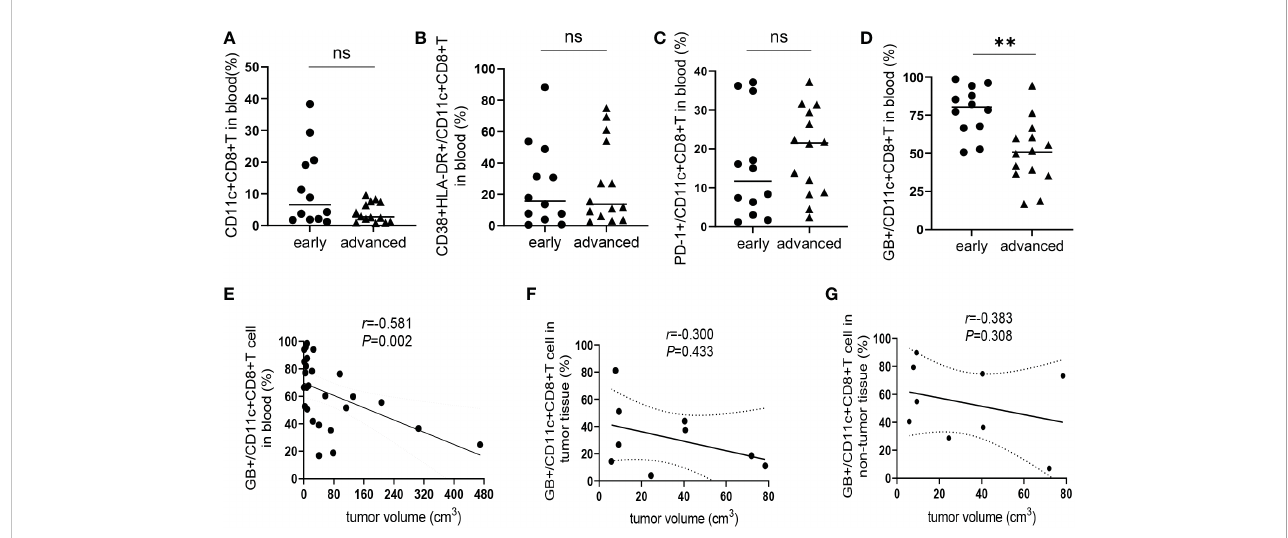
FIGURE 4 Correlation between CD11c + CD8 + T cells with estimated tumor volume. (A) The frequency of CD11c + CD8 + T cells in the peripheral blood of early-stage group (n = 12) and advanced-stage group (n = 14) of HCC patients. (B – D) The levels of CD38 & HLA-DR, PD-1, and GB expression of peripheral CD11c + CD8 + T cells of early-stage group (n = 12) and advanced-stage group (n = 14) of HCC patients. (E) The correlation analysis between GB expression level in peripheral CD11c + CD8 + T cells and tumor volume of HCC patients (n = 26). (F, G) The correlation analysis between tumor volume and GB expression level in tumor and non-tumor in fi ltrating CD11c + CD8 + T cells of HCC patients (n = 9), respectively. The Mann-Whitney U test was used to compare the median values between the two groups. Spearman ’ s correlation coef fi cient was used to assess the correlation between the two variables. r , correlation coef fi cient. **P < 0.01; ns, not signi fi